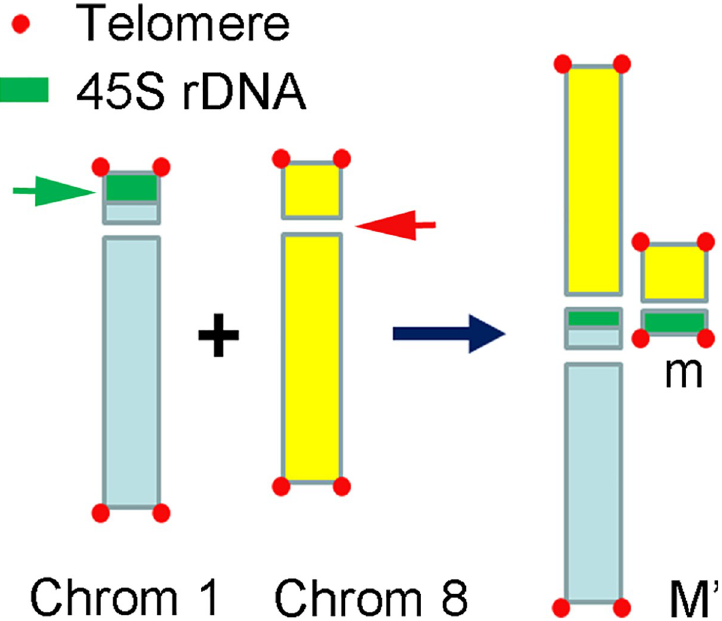
Fig 2. Ideogram showing the occurrence of fusion between two A-type chromosomes to form the M’-type chromosome and m-type chromosome. Chromosome fusion occurred between chromosome 1 (1) and chromosome 8 (8) after two breaks, one (green arrow) within the array of tandem repeats of 45S rDNA (green) on chromosome 1 and another (red arrow) at the centromeric region of chromosome 8.